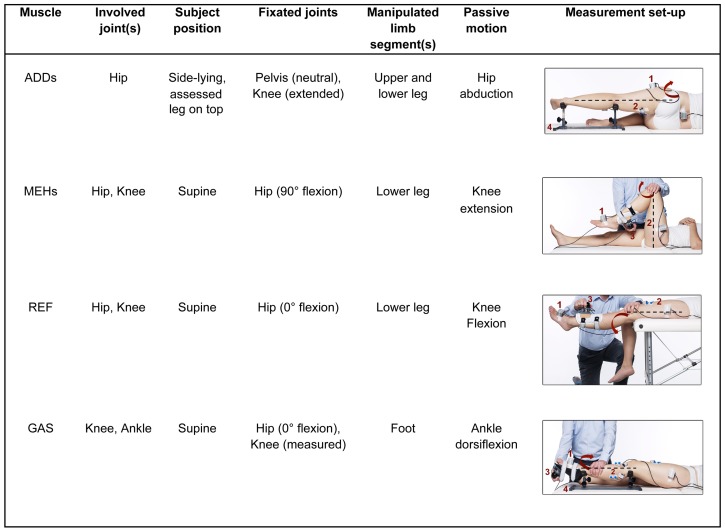
Measurement procedure for four lower limb muscles.ADDs, adductors; MEHs, medial hamstrings; REF, rectus femoris; GAS, gastrocnemius. The arrow indicates the direction of joint movement during stretch. Instrumentation: (1) two inertial measurement units (joint angle measurement); (2) surface electromyography (muscle activation measurement); and (3) a six DoF force-sensor attached to a shank or foot orthotic (torque measurement); (4) support frame.